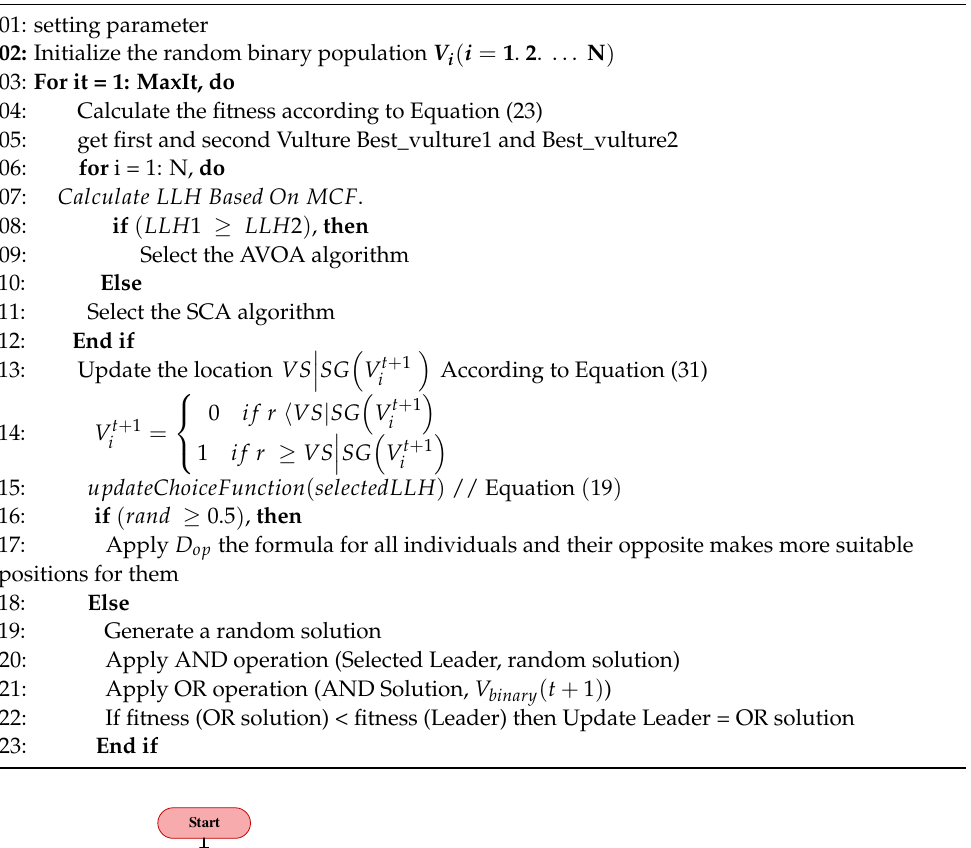
Algorithm 2: BAOVAH based S-shape and V-shape.